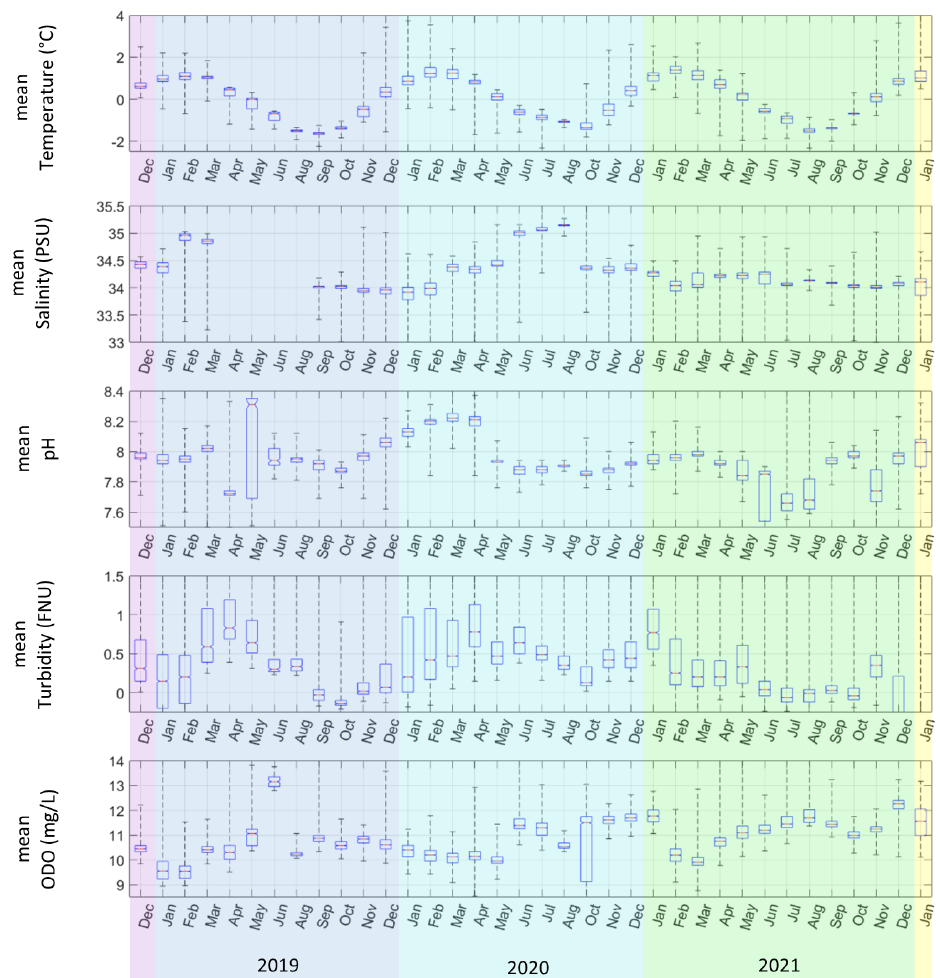
Figure 7. Box plot of monthly properties’ mean values (excluding properties measured solely by EXO2 sonde devices due to their signifi- cantly shorter time